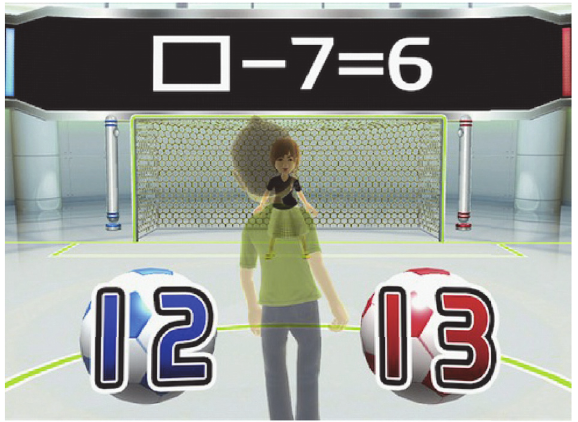
Figure 1: Mathematic game, user has to choose the answer by kicking the right ball and complete the